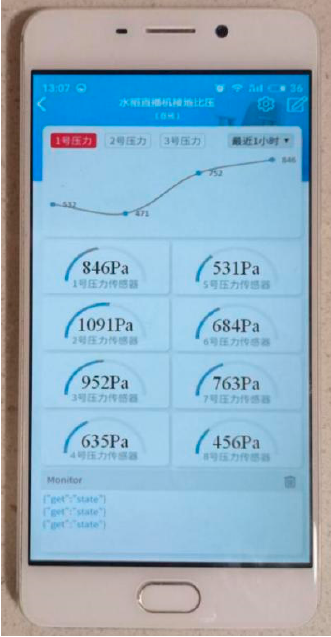
Figure 10. Internet of things measurement system—mobile terminal.